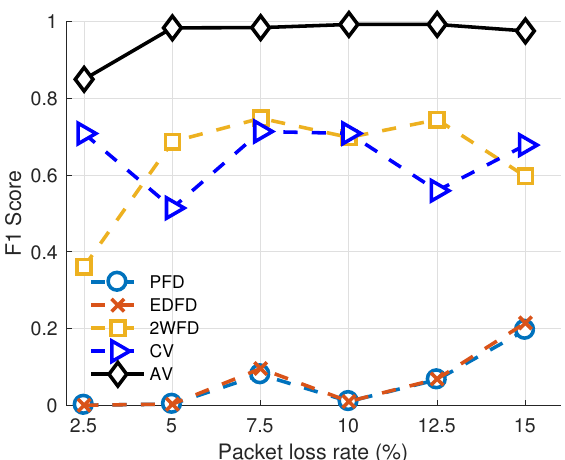
Figure 4. Performance of Evaluation model vs. packet loss